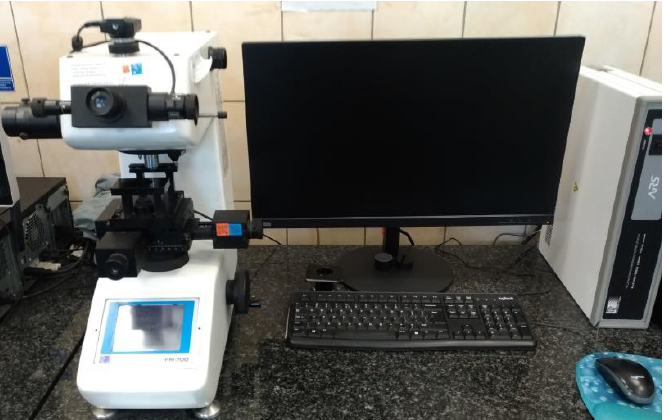
Figure 7. Hardness research station equipped with microhardness tester, Future-Tech Corp., Type: FM-700.